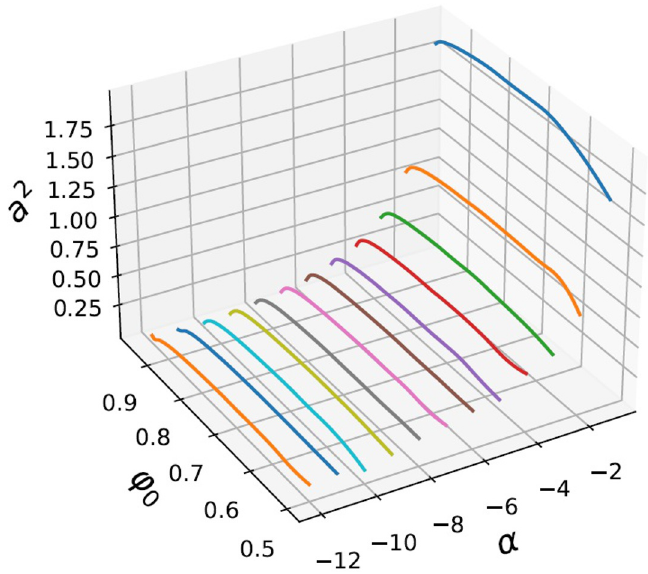
Figure 18 . The squashing a 2 as a function of the two parameters, ϕ 0 and α , for Bolt end- point solutions.